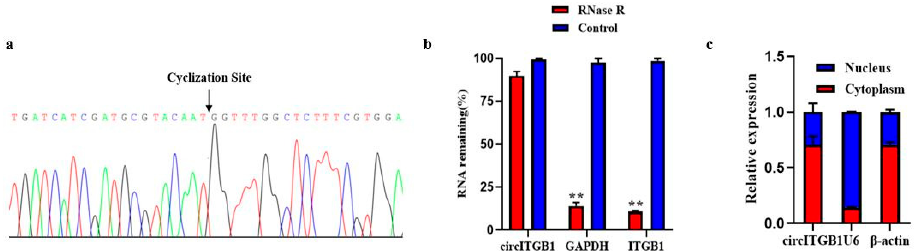
Figure 1. Authenticity identification of CircITGB1 in adipocytes. ( a ) Sanger sequencing of circITGB1 backsplice junctions. ( b ) Relative expression levels of circITGB1 and ITGB1 after RNase R treatment for 30 min, using GAPDH as a reference. ( c ) After nuclear separation, the relative expression of circITGB1 in the nucleus and cytoplasm, using U6 and β -actin as reference. ** p < 0.01.